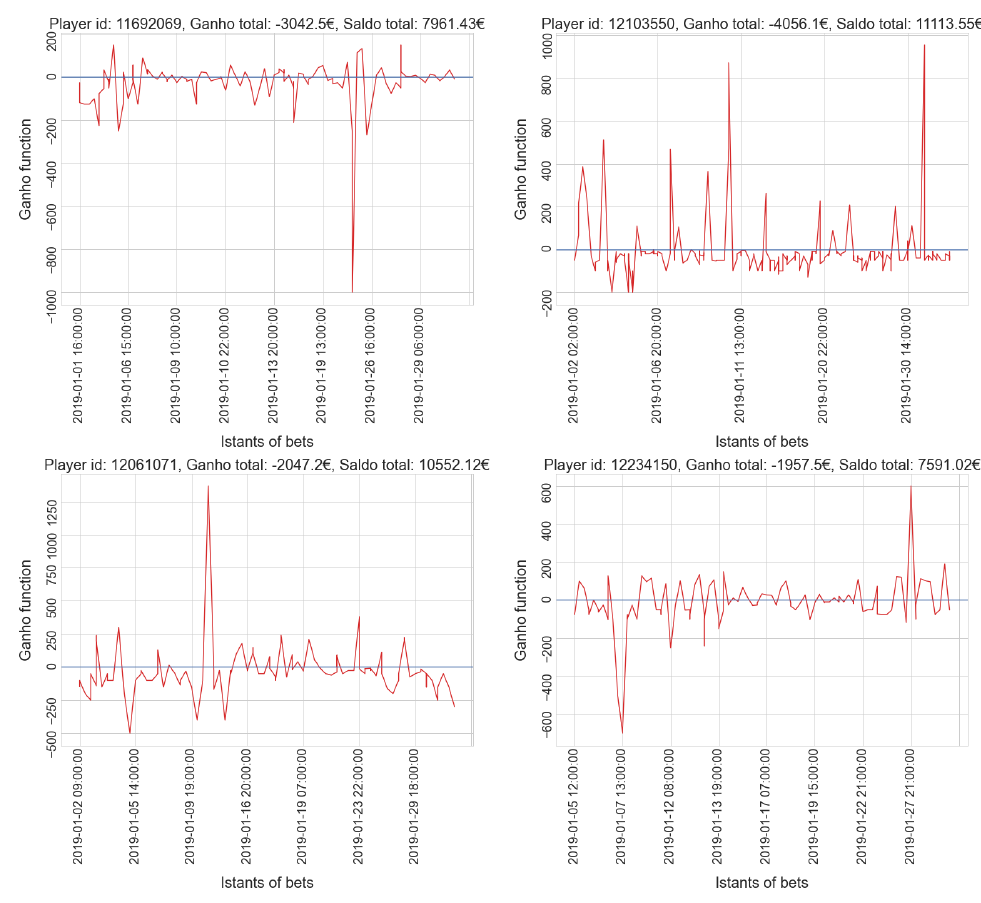
Figure 11. Time series plot of four potential high-risk pathological